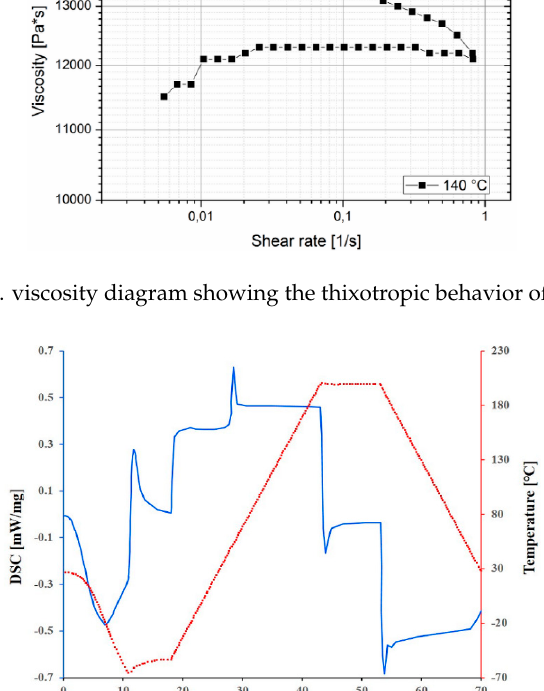
Figure 4. Shear rate vs. viscosity diagram showing the thixotropic behavior of Purasorb PDLG 5010.